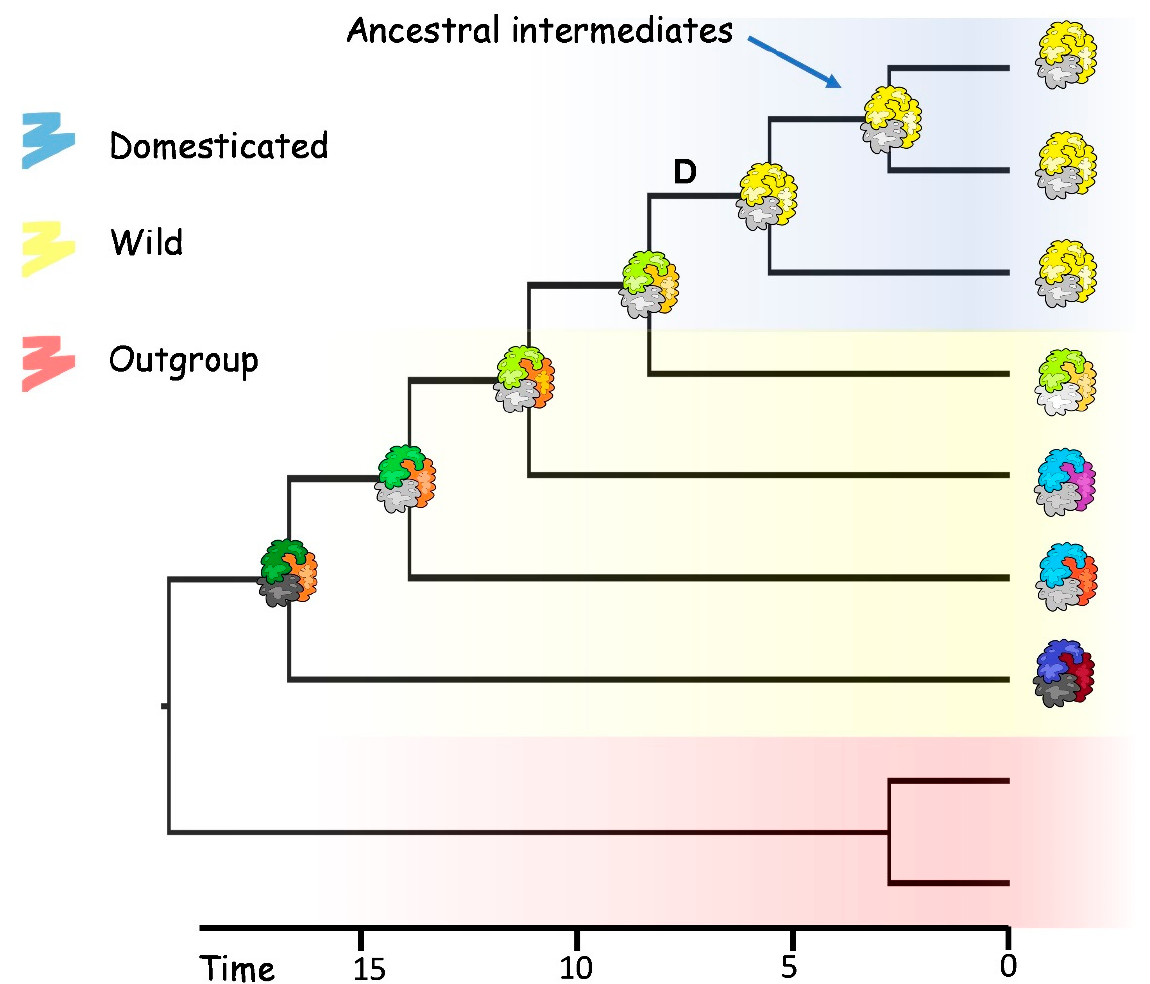
Figure 2. An example of reconstruction of putative ancestral intermediates by inferring the phylo- genetic relationship between modern homologs. ASR studies can explore biodiversity to infer the historical evolution of natural proteins. Statistical models of amino acid substitution can be applied to calculate the sequences at internal nodes. Although domestication (D) has produced bottlenecks and reduced the genetic variability, ASR analyses can be applied to wild crop relatives.